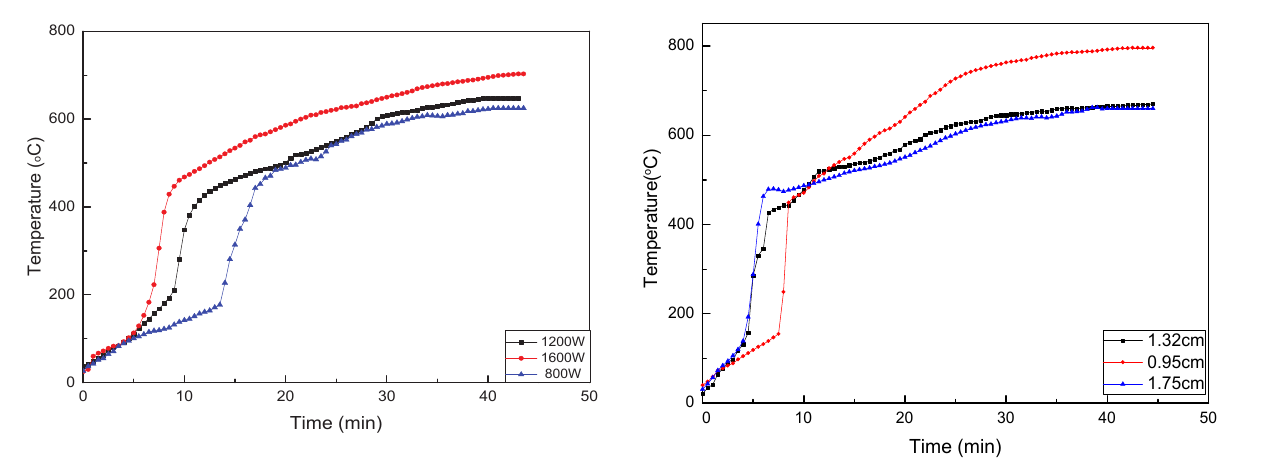
Figure 9: The temperature characteristic curve of different material layer